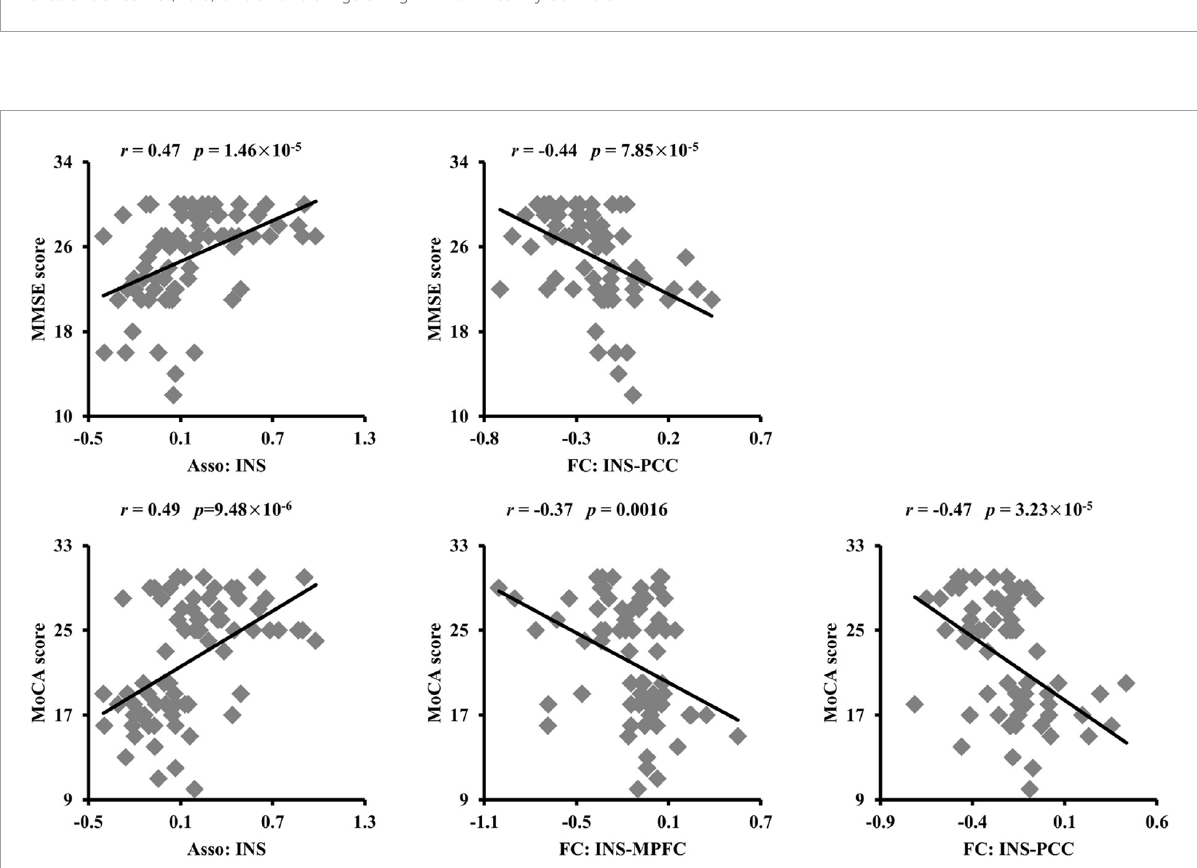
FIGURE4 Significant correlations between the association ability, functional connectivities, and cognitive performances. The association ability (Asso) of left dorsal anterior insula (INS) was positively correlated with Mini-Mental State Examination (MMSE) and Montreal Cognitive Assessment (MoCA) scores. The functional connectivity between INS and posterior cingulate cortex (PCC) was negatively correlated with MMSE. The functional connectivities between INS and PCC, medial prefrontal cortex (MPFC) were also negatively correlated with MoCA